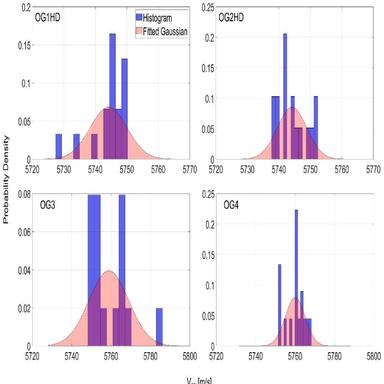
Fitted Gaussian distributions for experimental data from each sample.